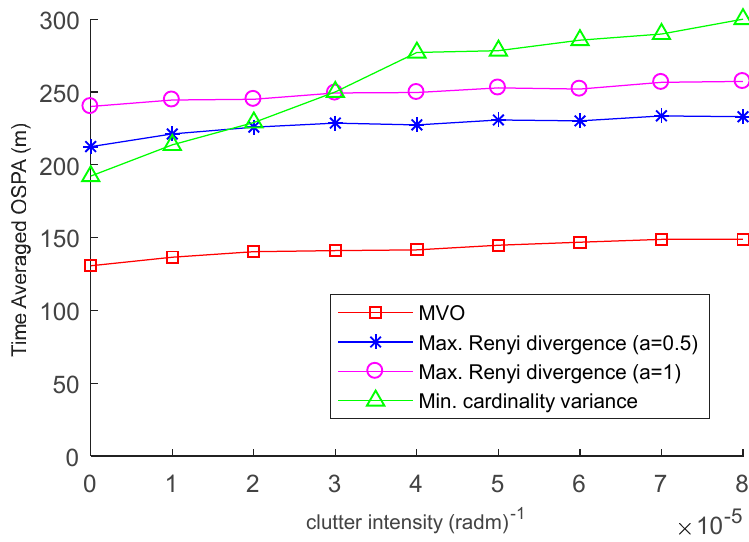
Figure 6. Time-averaged OSPA distances for varying clutter intensity.